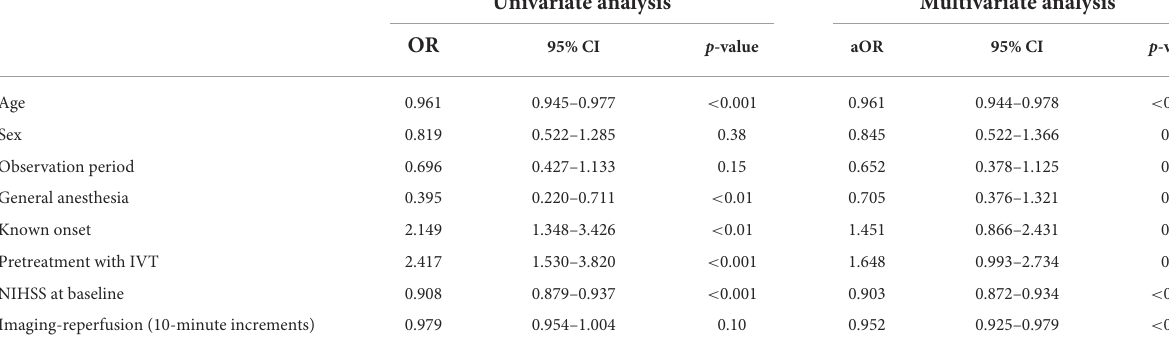
TABLE 4 Delay from imaging to reperfusion and functional